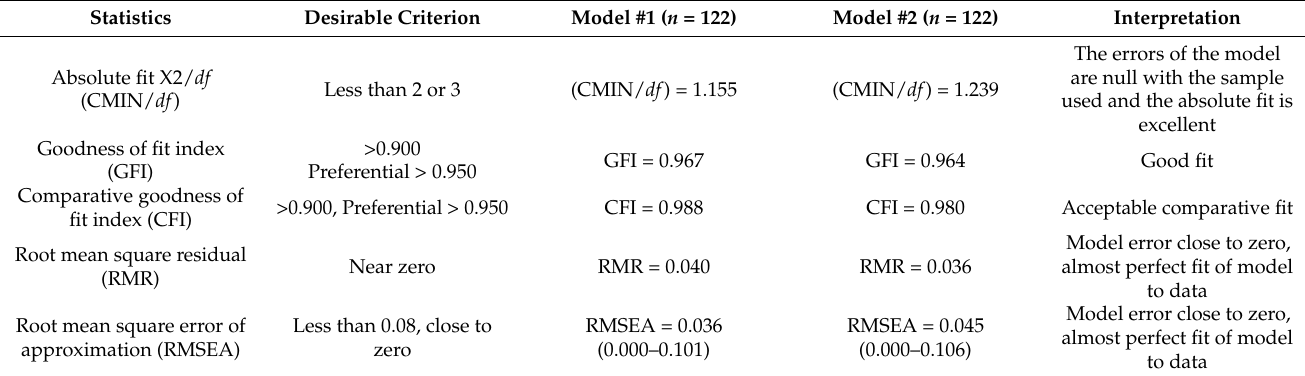
Table 2. Goodness of fit indices of the confirmatory model resulting from 2 factors in kidney patients ( n = 242) using the method of maximum likelihood.